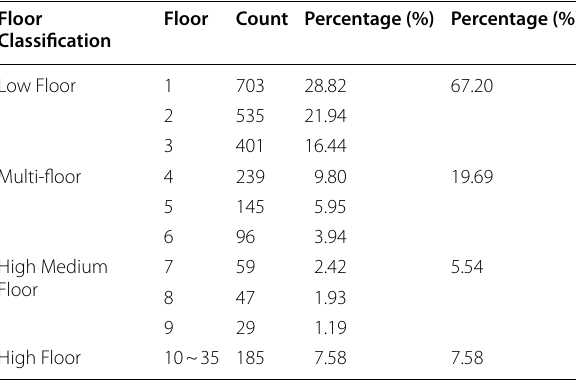
Table 2 Floor statistics of out-of-school hours care places in Xi’an in autumn 2021 Floor